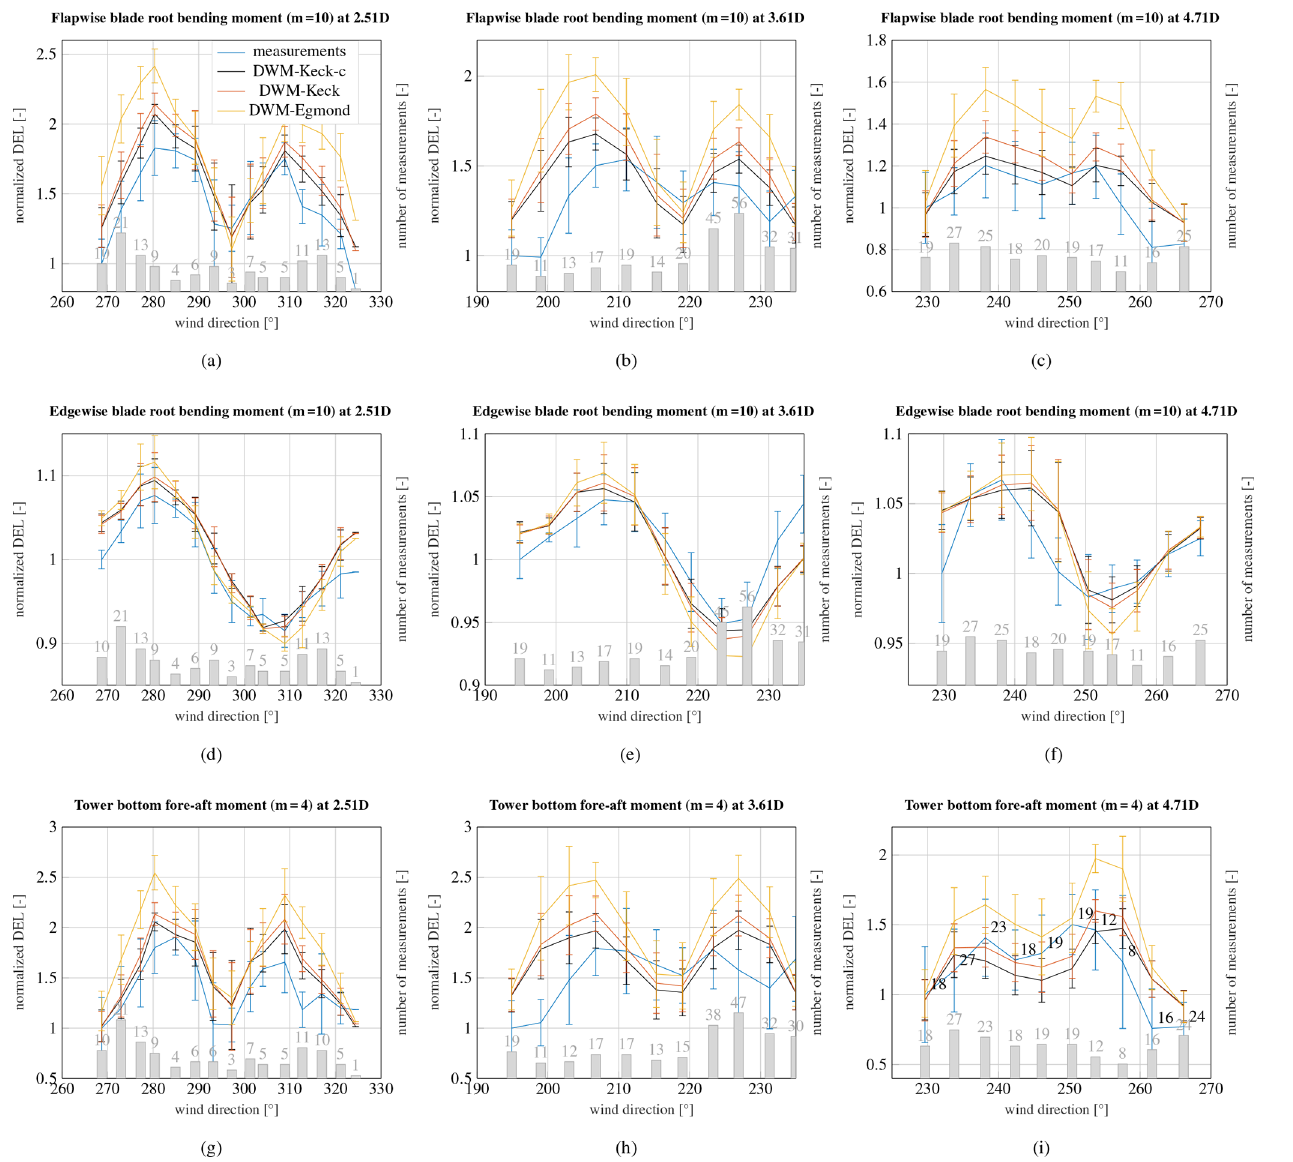
Figure 12. Measured and simulated flapwise blade root bending moment (a–c) , edgewise blade root bending moment (d–f) and tower bottom bending moment (g–i) . WTG 2 is exposed to the wake of WTG 1 in panels (a) , (d) and (g) , WTG 5 is exposed to the wake of WTG 2 in panels (b) , (e) and (h) , and WTG 5 is exposed to the wake of WTG 1 in panels (c) , (f) and (i) . The ambient wind speed is 8ms − 1 and the ambient turbulence intensity is 10%. The number of measured 10min time series in each wind direction bin is illustrated on the secondary